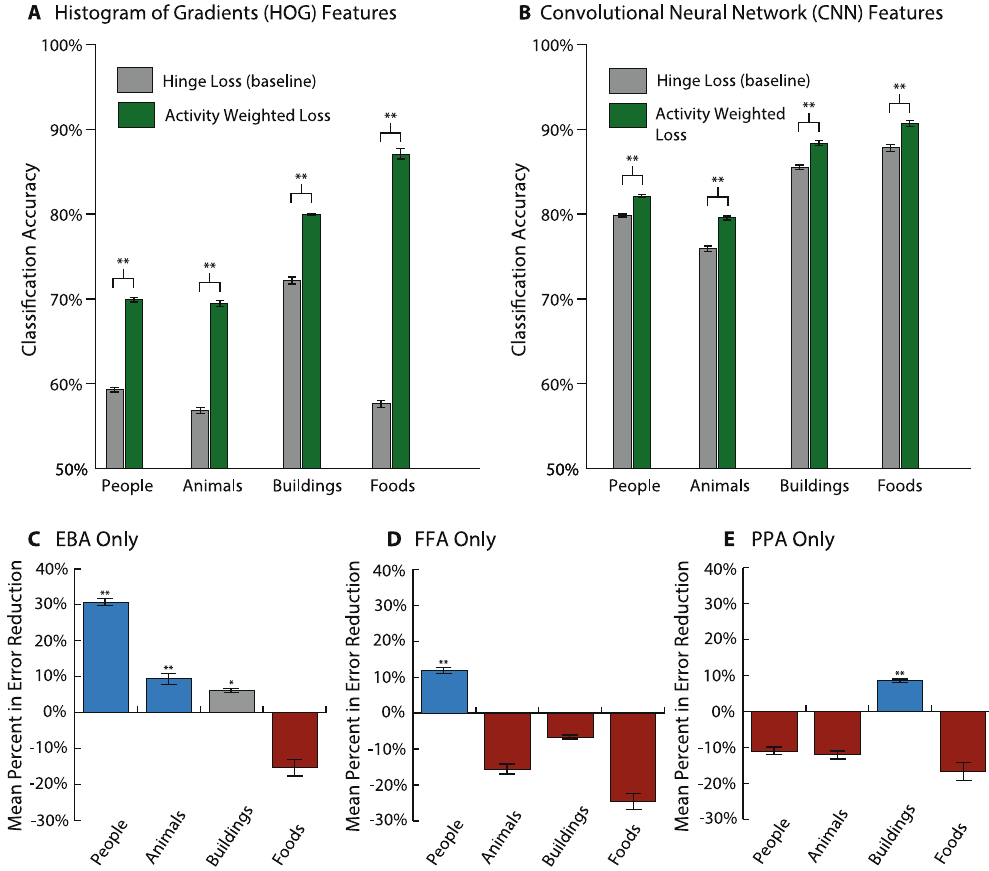
Figure 2. Results showing the effect of conditioning classification models for four visual classes on fMRI data during supervised training (Fig. 1). ( A , B ) Side-by-side comparisons of the mean classification accuracy between models that were trained using either ( A ) HOG features or ( B ) CNN features and either a hinge loss (HL) or activity weighted loss (AWL) function. These graphs show results of experiments that generated activity weights by using voxels from all seven higher-level visual ROIs (i.e., EBA, FFA, LO, OFA, PPA, RSC, and TOS). For each object category and choice of image features, the models trained using AWL were significantly better ( p < 0.01 via paired, one-tailed t-testing). While using AWL loss reduces misclassification error using both features, it particularly improves the performance of handcrafted HOG features. ( C–E ) Mean error reductions gained by switching from HL to AWL loss when using conditioning classifies on brain activity from individual ROIs (i.e., EBA, FFA, or PPA) show that certain areas produce significantly better results for the specific categories they are selective for. Error bars are standard error over 20 trials in all